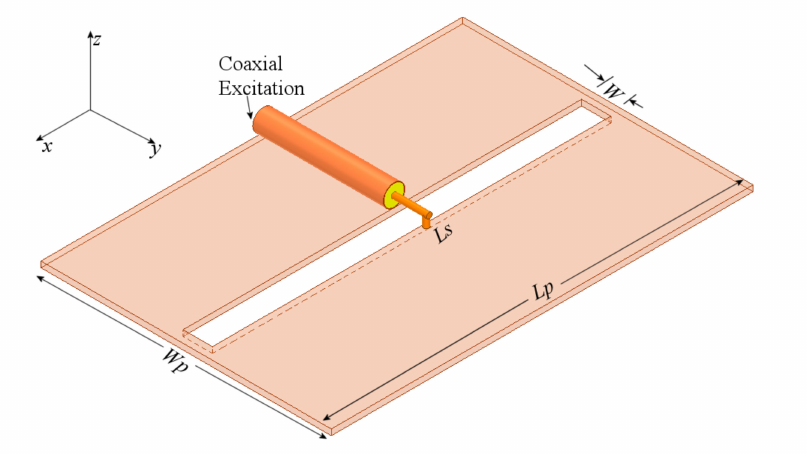
Figure 1. Slot radiator excited by a coaxial